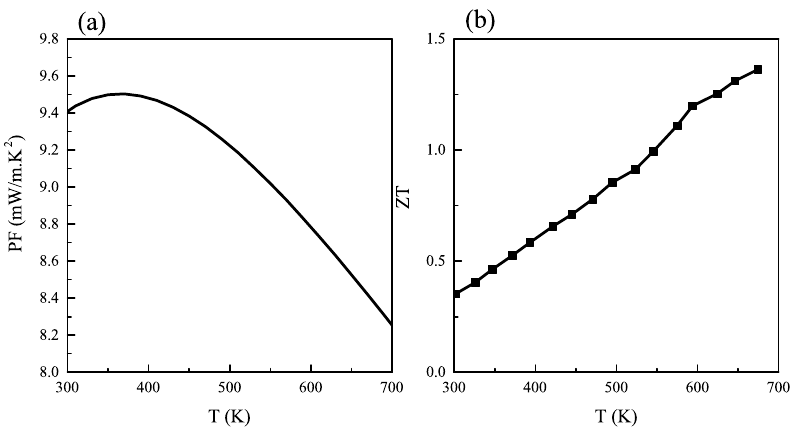
Figure 7. Variation of ( a ) power factor; and ( b ) figure of merit with temperature in kesterite Cu 2 ZnGeS 4